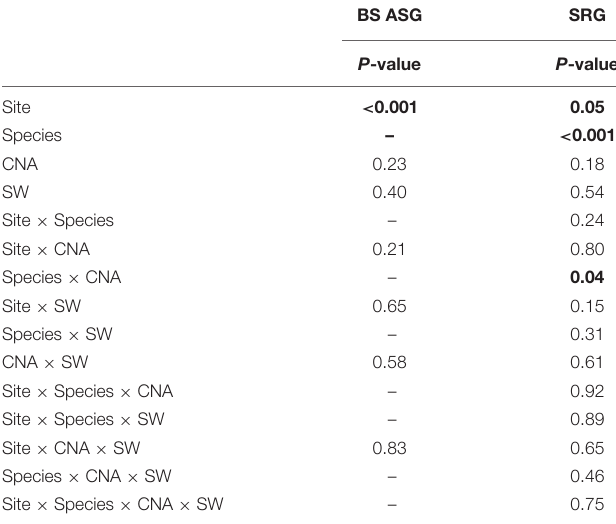
TABLE 2 | Result of the mixed model analysis conducted on black spruce annual shoot growth (BS ASG) and stem radial growth of black spruce and balsam fir (SRG) between June 2015 and August 2016 (two growing seasons) with site, species, canopy N addition (CNA), and soil warming (SW) as fixed effects and blocks as random